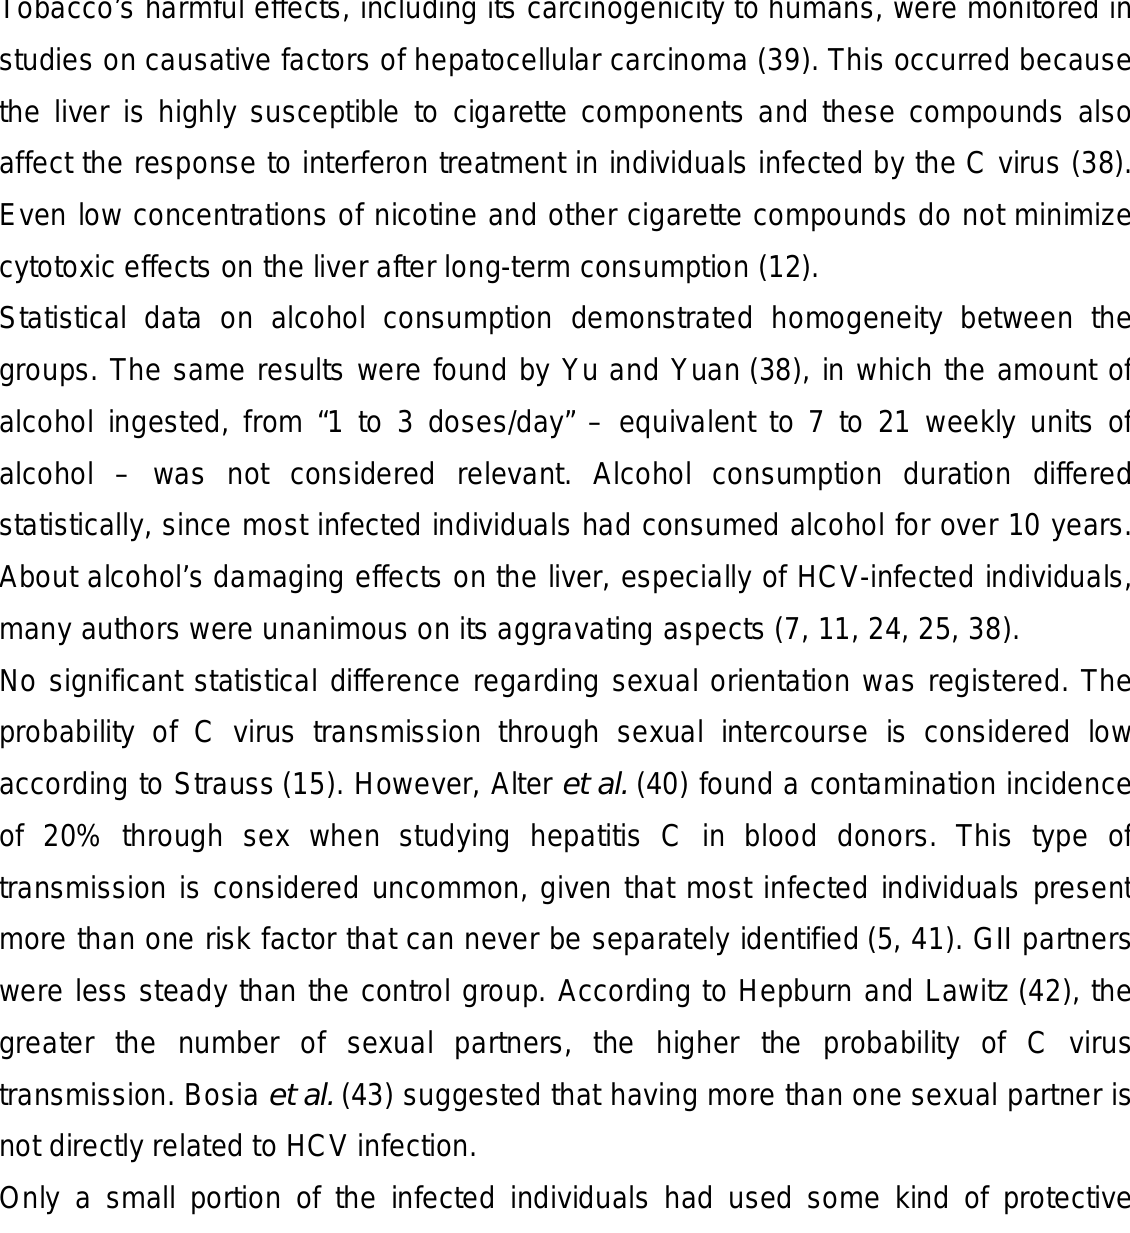
Felippe MJDB, Meira DA. Comparison of risk factors among blood donors, volunteers and replacement individuals, infected or not by Hepatitis C virus. J Venom Anim Toxins incl Trop Dis.